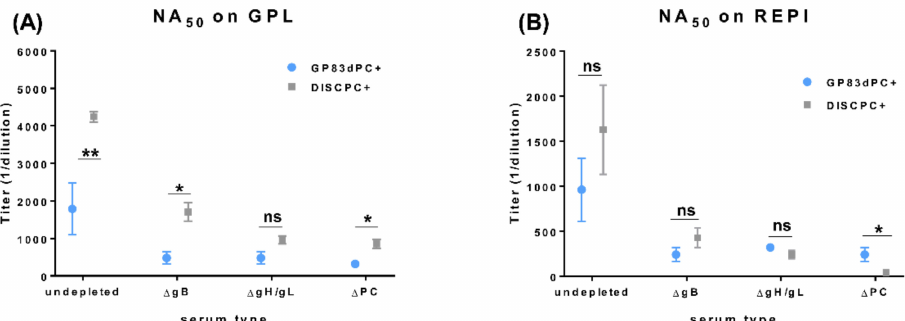
Figure 4. DISC(PC+) vaccine vs. GP83dPC+ vaccine for GPCMV neutralization by complete or sera depleted of antibodies to specific viral glycoprotein complexes (gB or gH/gL and PC). Neutralizing antibody titers (NA 50 ) on different cell types of pre- and post-glycoprotein-complex antibody depleted vaccine sera. Pooled sera from GP83dPC+ vaccinated animal group or historical DISC(PC+) pooled vaccine sera [36] were tested for NA 50 against wt GPCMV (PC+) on GPL fibroblast or REPI epithelial cells. ( A ) Antibody neutralization of wt GPCMV (PC+) using pre- (native) or post-gB ( ∆ gB)-, post-gH/gL ( ∆ gH/gL)-, or post-PC ( ∆ PC)-depleted sera on the GPL cell line. ( B ) Antibody neutralization of GPCMV with pre- or post-depleted sera tested on the REPI cell line. * p < 0.05; ** p < 0.005; ns = non-significant, Student’s t